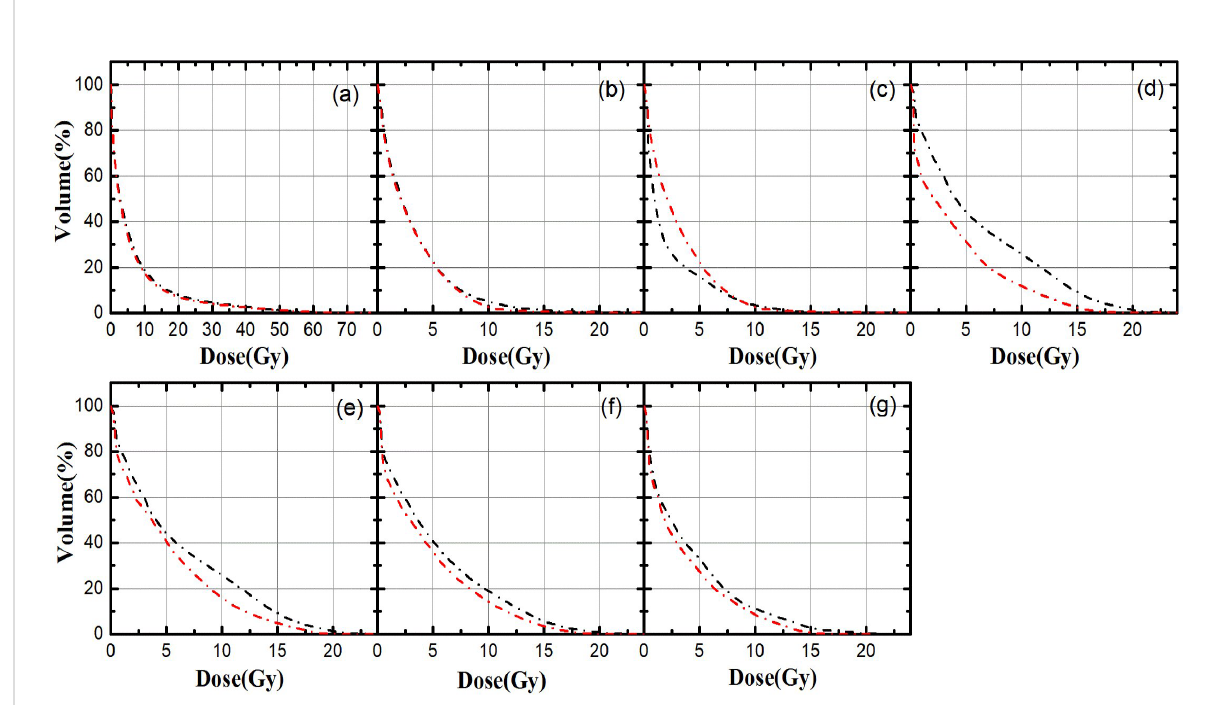
FIGURE 3 The average dose volume histograms of OARs in Plan S and Plan D; (A) combined lungs, (B) heart, (C) spinal cord, (D) trachea, (E) bronchus, (F) combined the trachea and bronchus, (G) esophagus; black line indicate Plan S, red line indicate Plan